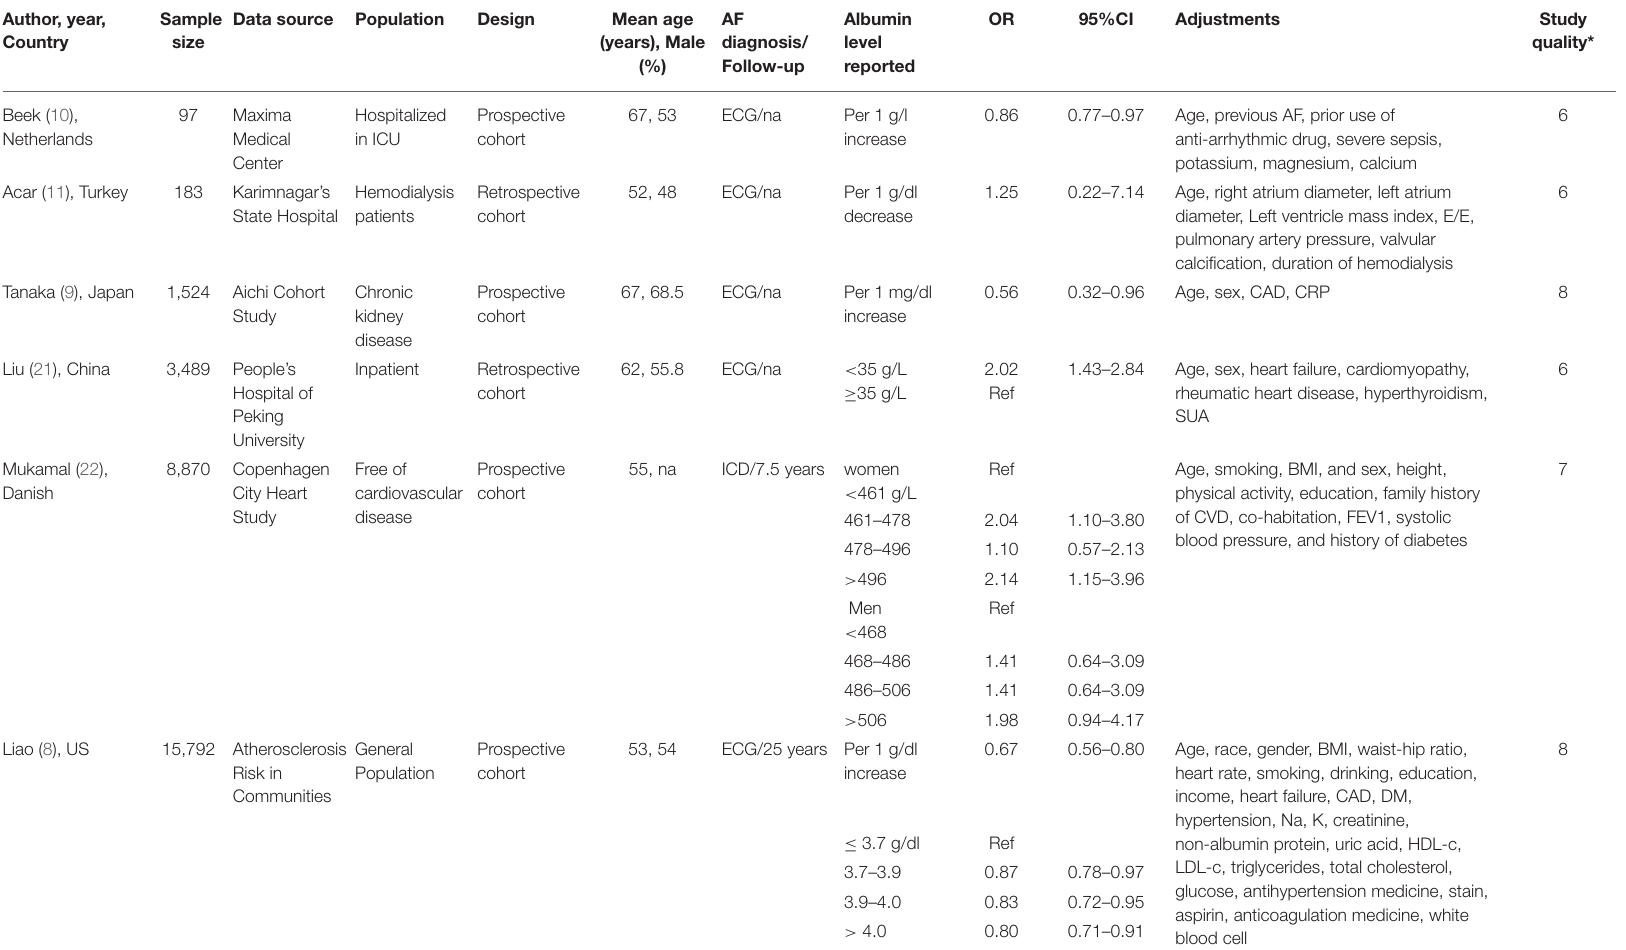
TABLE 1 | Baseline characteristic of included studies in the association between serum albumin and atrial